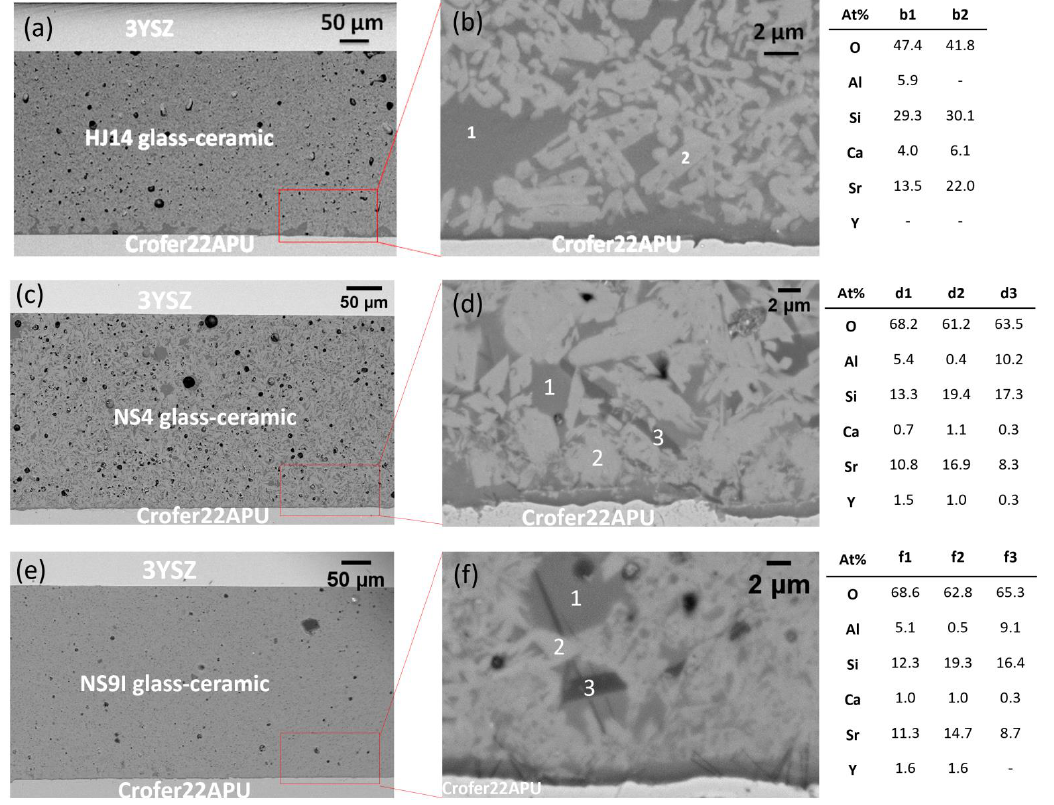
Figure 3. SEM backscattered electron images of the as-joined Crofer22APU/glass-ceramic/3YSZ joined samples at different magnifications, together with an EDS elemental analysis (at.%) of the marked points: HJ14 glass-ceramic ( a , b ); NS4 glass-ceramic ( c , d ); NS9I glass-ceramic ( e , f ).